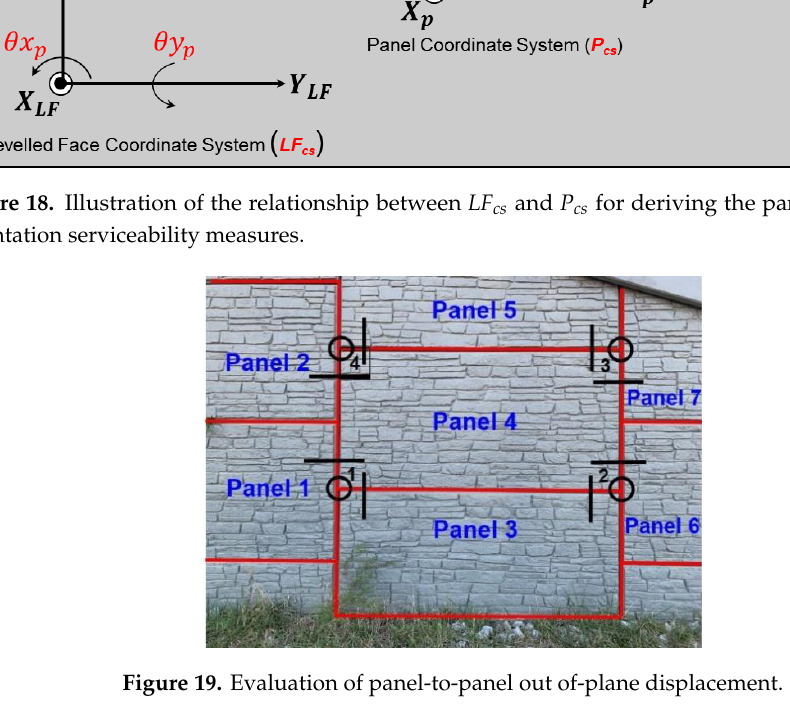
Figure 19. Evaluation of panel-to-panel out of-plane displacement.